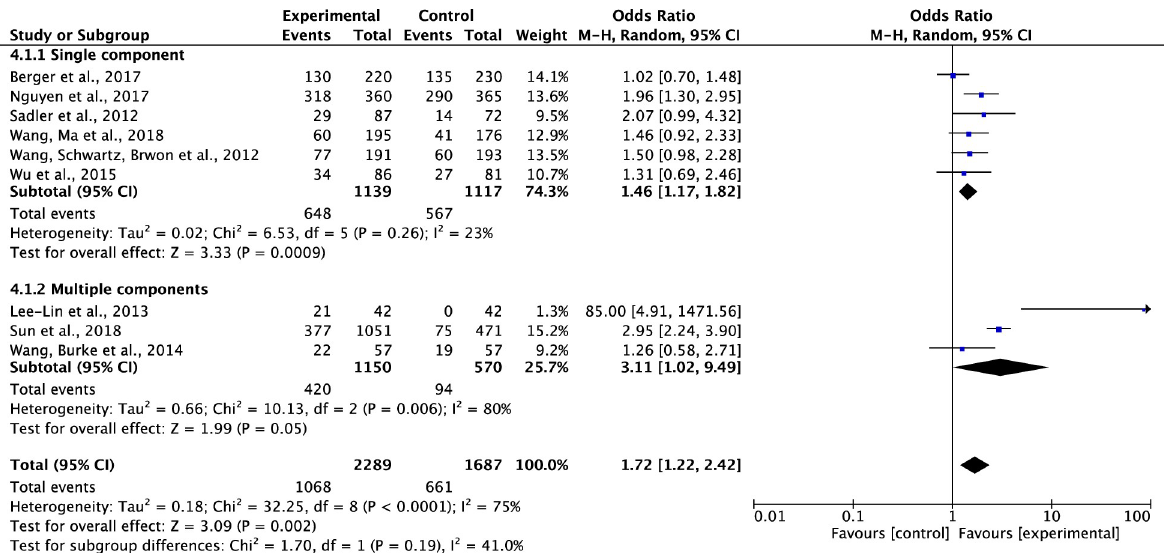
Fig 8. Forest plot of single component VS. multiple-component interventions on participants’ completion of cancer screening.